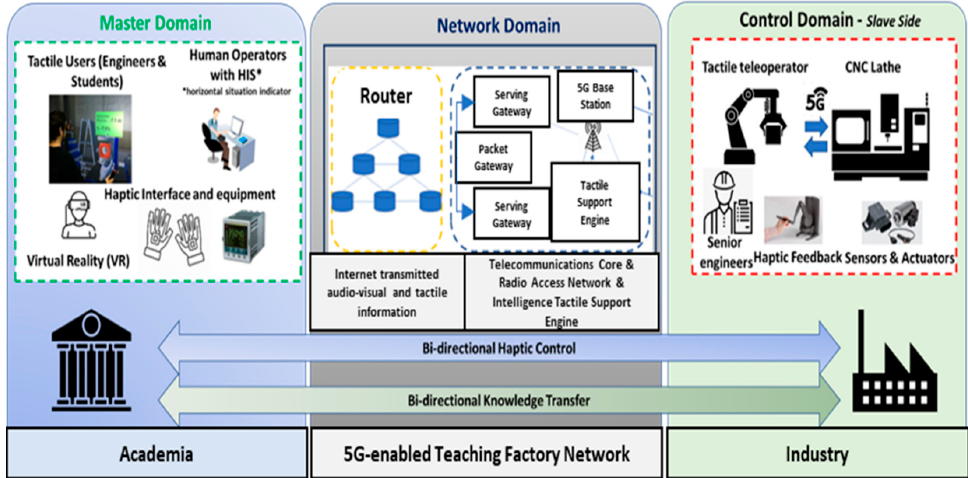
Figure 18. A generalized architecture of a wireless tactile internet system in a teaching factory [69].